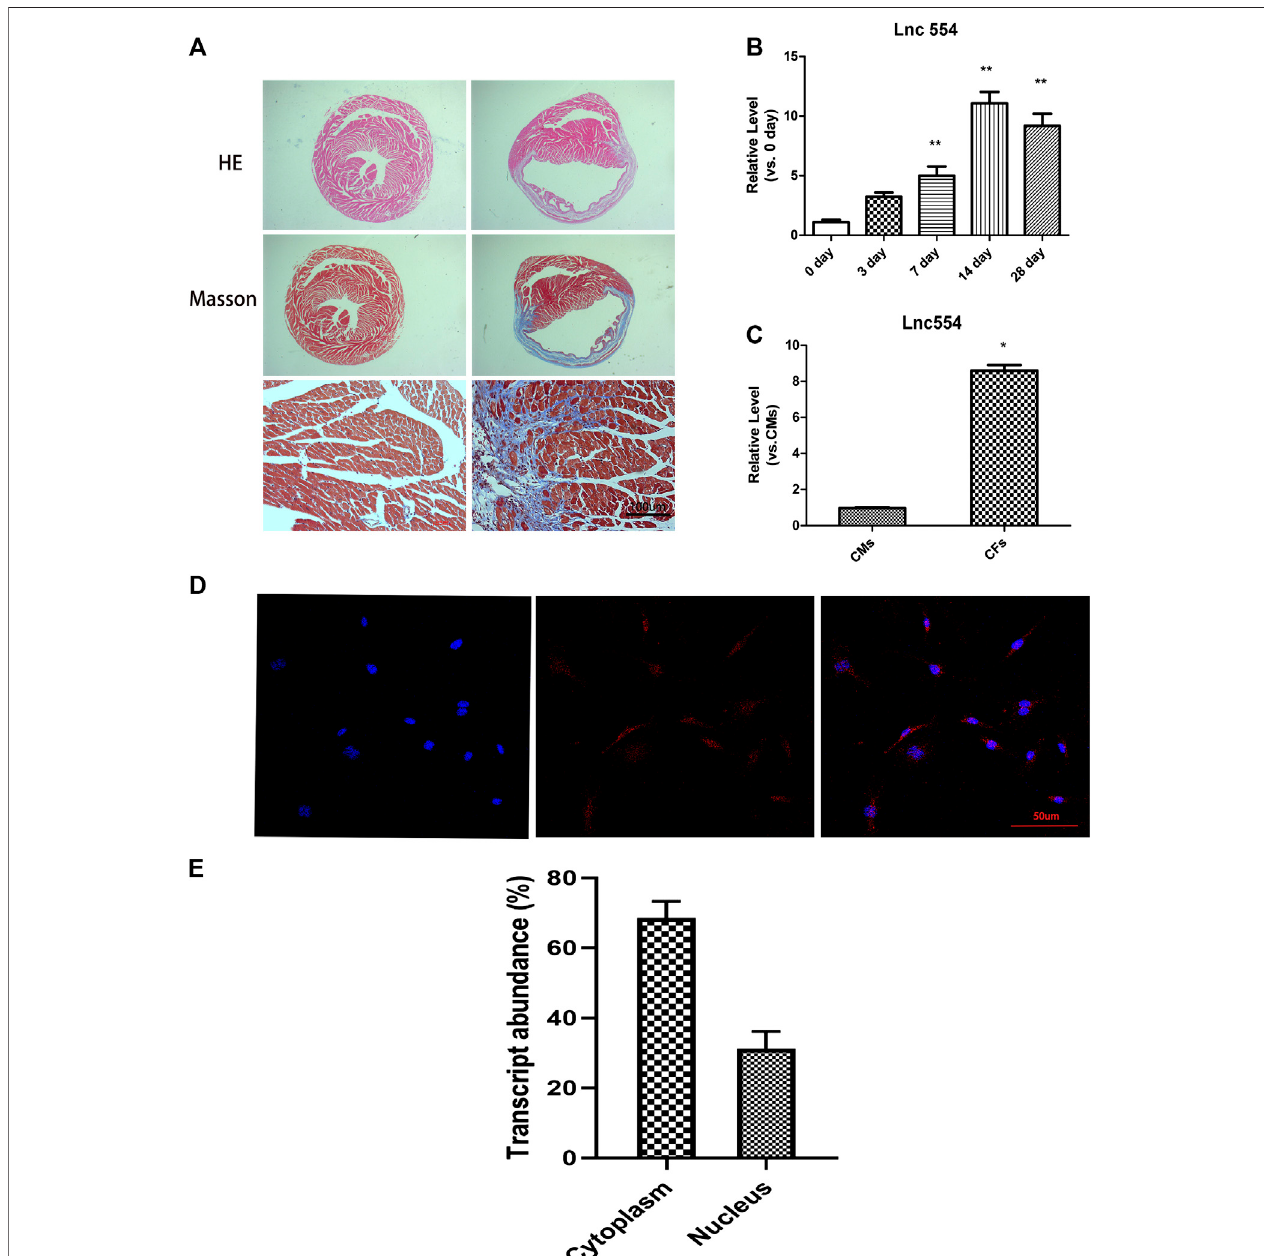
FIGURE 1 | LncRNA 554 is upregulated after myocardial infarction and is enriched in cardiac fi broblasts. Two weeks after MI, the hearts of mice were stained by hematoxylin-eosinstainingandMasson ’ strichromestaining (A) .Scalebars,100 μ mn (cid:2) 8miceineachgroup; (B) qRT-PCRwereconductedtodetecttheexpressionof lncRNA 554 in the border zone of mice at different time (0, 3, 7, 14, 28 days) after MI. ** p < 0.01 vs 0 day, n (cid:2) 8; (C) qRT-PCR were conducted to detect lncRNA 554 levels in CMs and CFs. * p < 0.05 vs CMs, n (cid:2) 5. Representative fl uorescent in situ hybridization images; (D) and corresponding statistical chart; (E) showing the expression abundance and cellular localization of lncRNA 554 in CFs. Scale bars, 50 μ m n (cid:2) 10.